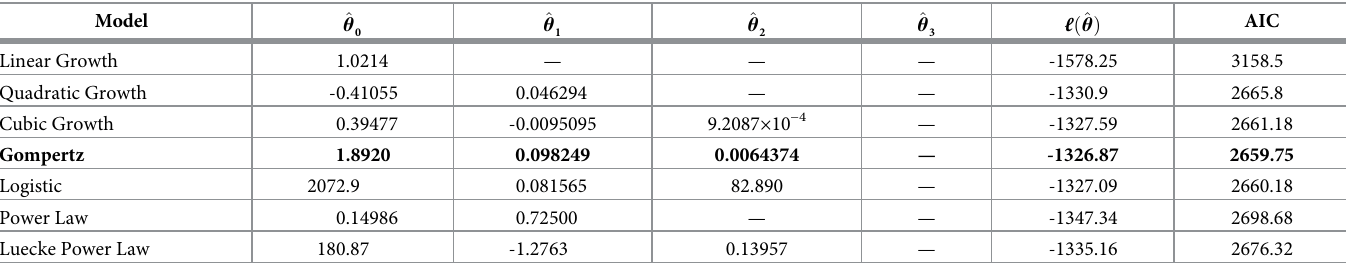
Table 28. Models for fetal blood flow through the ductus venosus (mL/min vs. fetal mass in g for power law models, mL/min vs. gestational age in weeks for all other models). Model